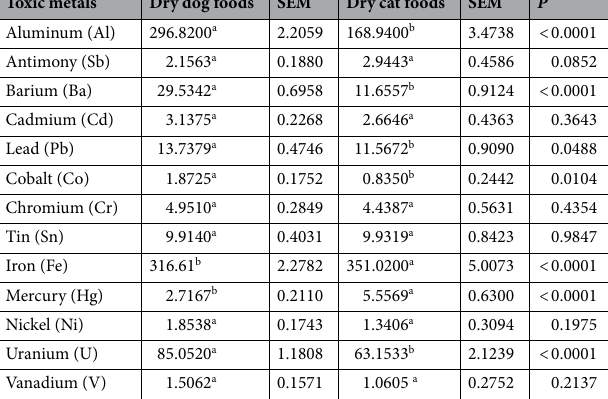
Table 8. Comparison of detected toxic metals concentrations (mg/kg) between dry foods for dogs and cats. SEM standard error mean, P probability of significance. a,b Means followed by different letters in the lines differed (P <